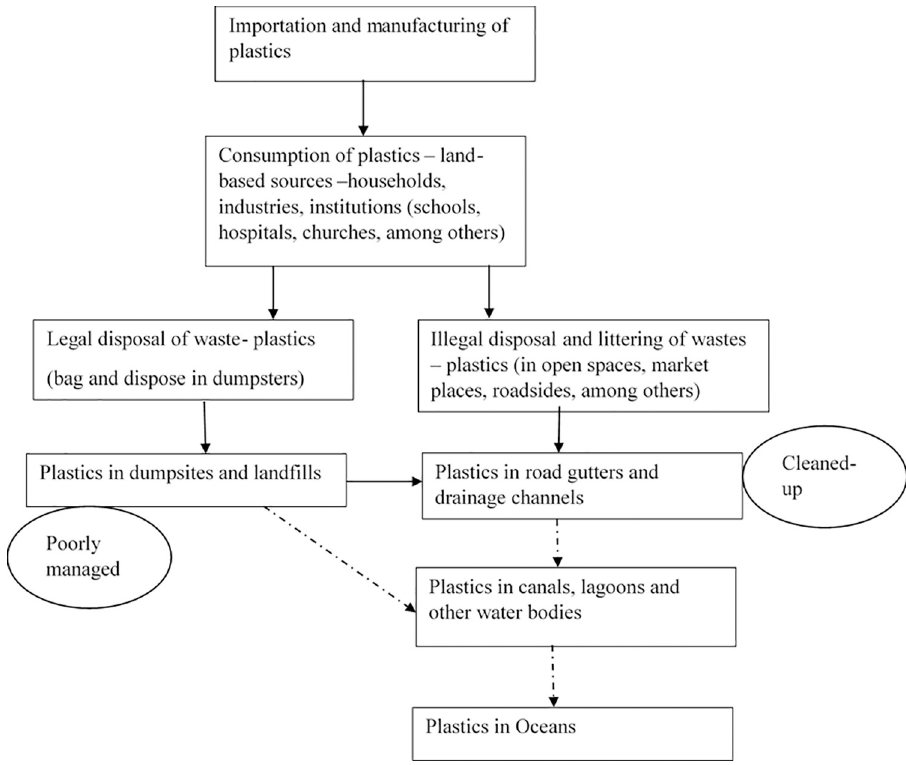
Fig 1. Conceptual framework showing the pathway of generation of plastics and their flow into the